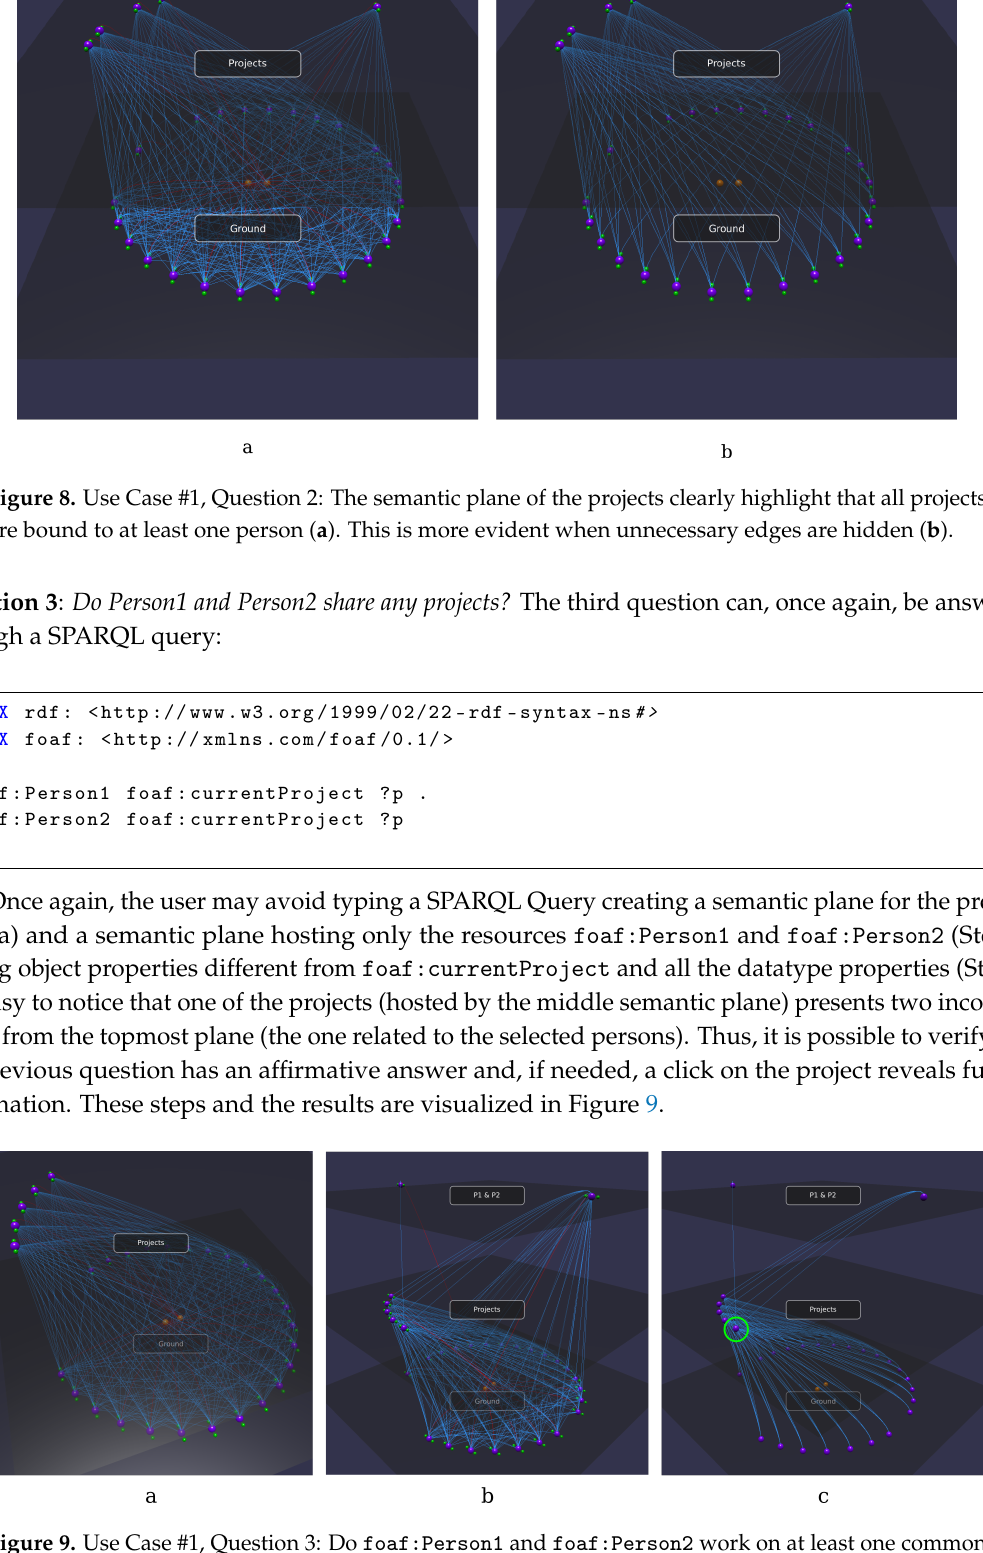
Figure 9. Use Case #1, Question 3: Do foaf:Person1 and foaf:Person2 work on at least one common project? To answer this question we start creating a semantic plane hosting all the projects ( a ). Then, a second plane hosting foaf:Person1 and foaf:Person2 is created ( b ). Hiding unnecessary edges, it is easy to identify a project where both work together ( c